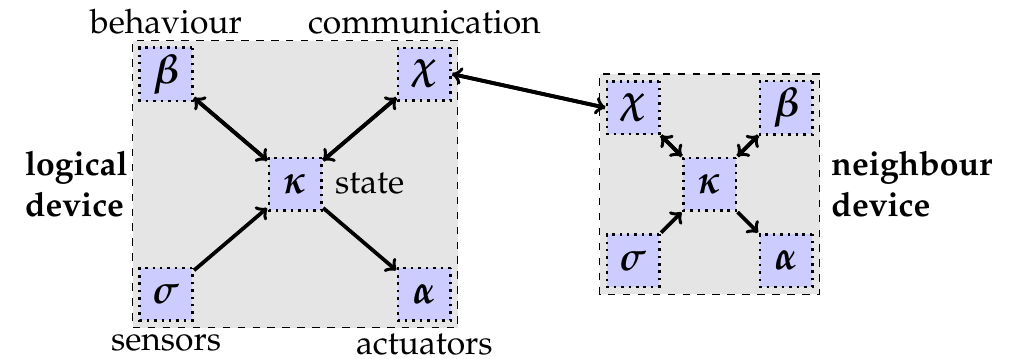
Figure 2. A logical device, split into sub-components, and one of its